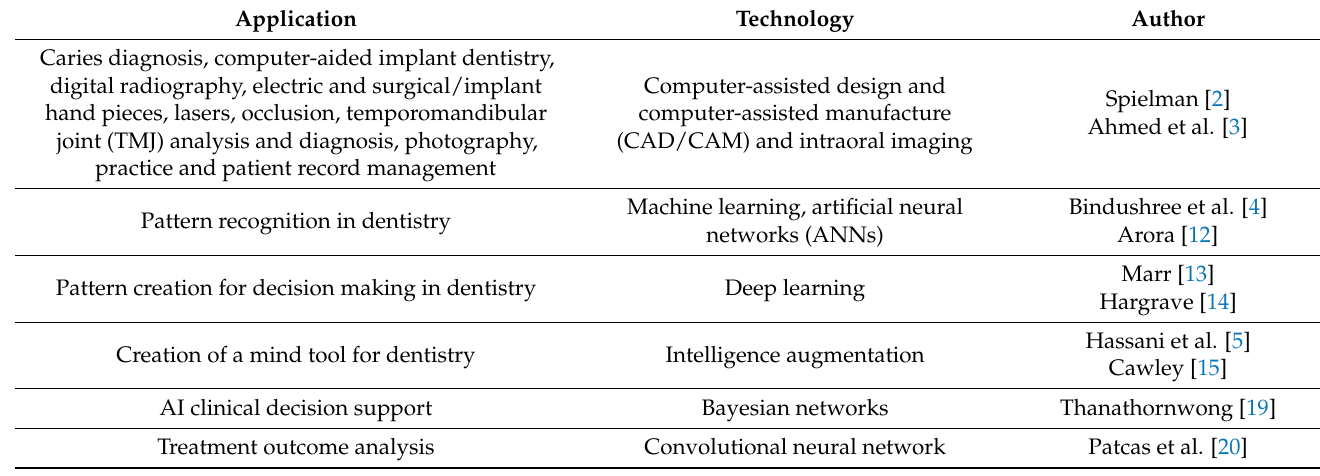
Table 2. Overview of dental applications and